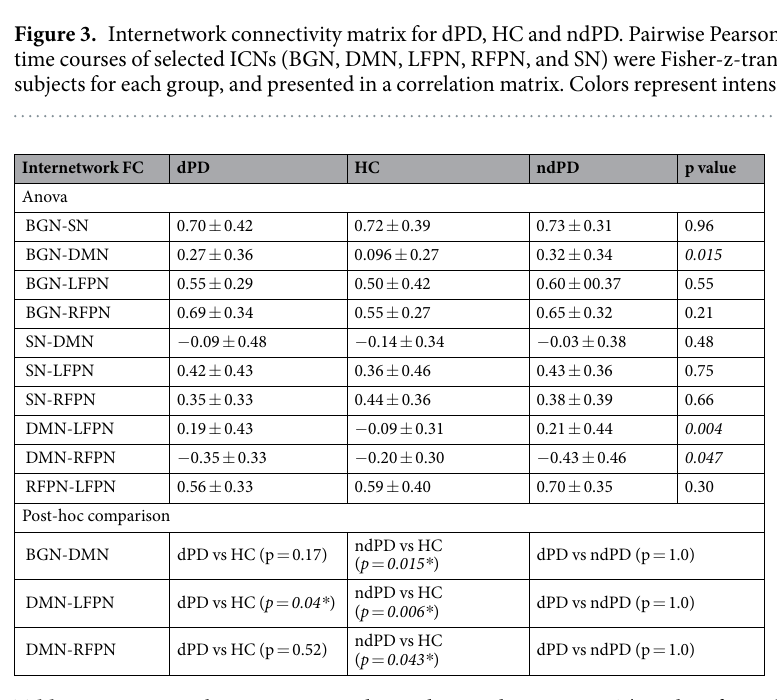
Table 4. Internetwork connectivity in dPD, ndPD, and HC groups. The values for each group are denoted by the mean and standard deviation of connectivity value. Italics indicate p < 0.05; * Significant for p < 0.05, Bonferroni corrected for multiple comparisons. Abbreviations: BGN, basal ganglia network; DMN, default- mode network; LFPN, left frontoparietal network; RFPN, right frontoparietal network; SN, salience